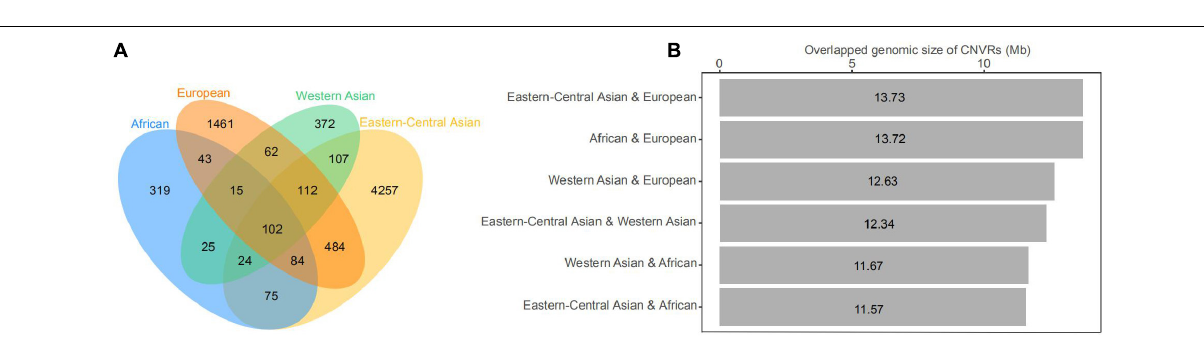
FIGURE 4 | (A) Venn diagram of the number of copy number variations (CNVs) shared by geographic groups of domestic sheep, including African, Eastern-Central Asian, European, and Western Asian populations. (B) Histogram of genomic coverage by CNV regions (CNVRs) shared by two geographic groups of domestic sheep